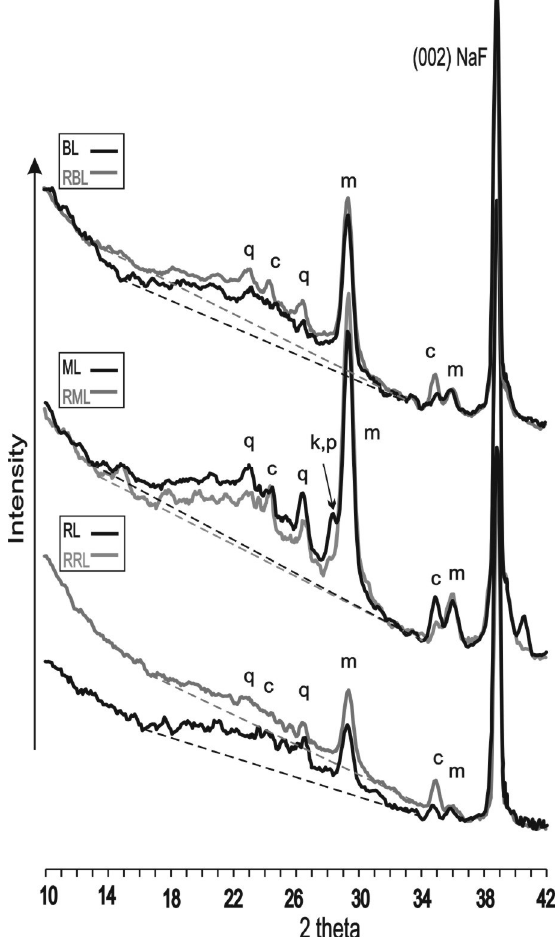
Figure 9. Diffractograms of pyrolyzed leaves and their pyrolyzed after-extraction residues: q—quartz, k—K-feldspar (e.g., microline), p—plagioclase feldspar (e.g., albite, anorthite), c—calcite, m—magnetite (magnetite and maghemite